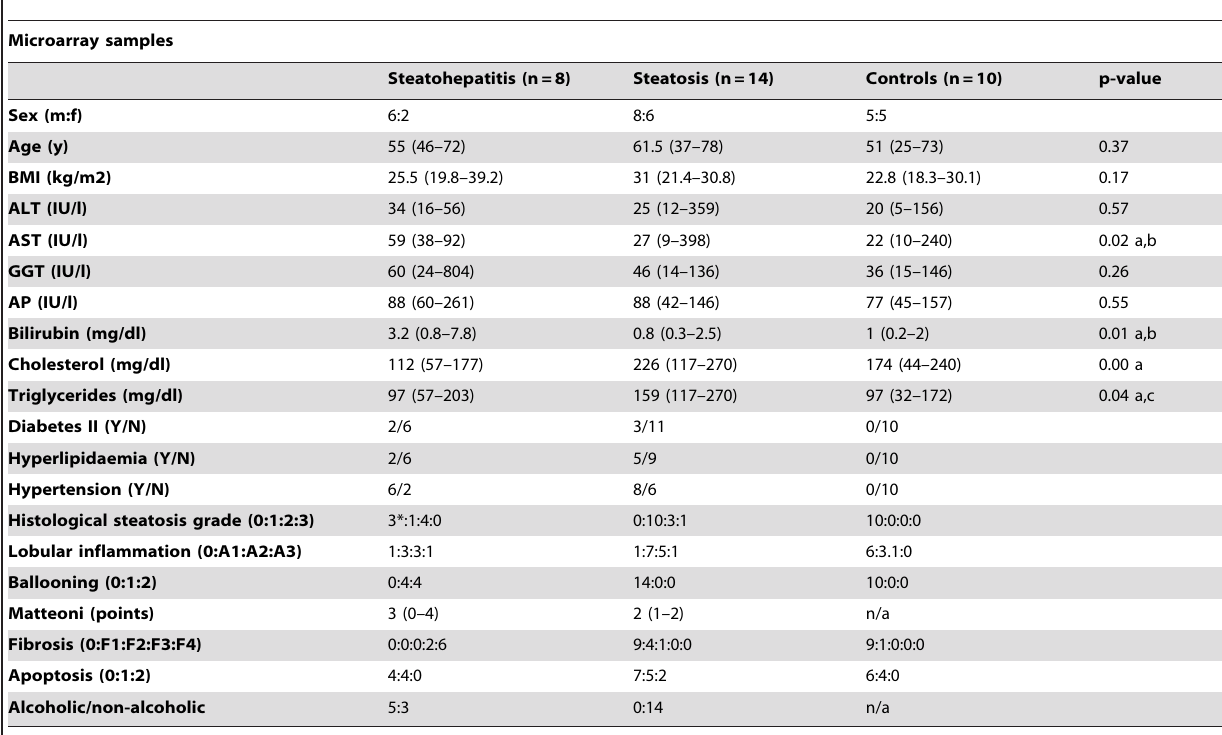
Table 1. Clinical, biochemical and histopathological patient characteristics.